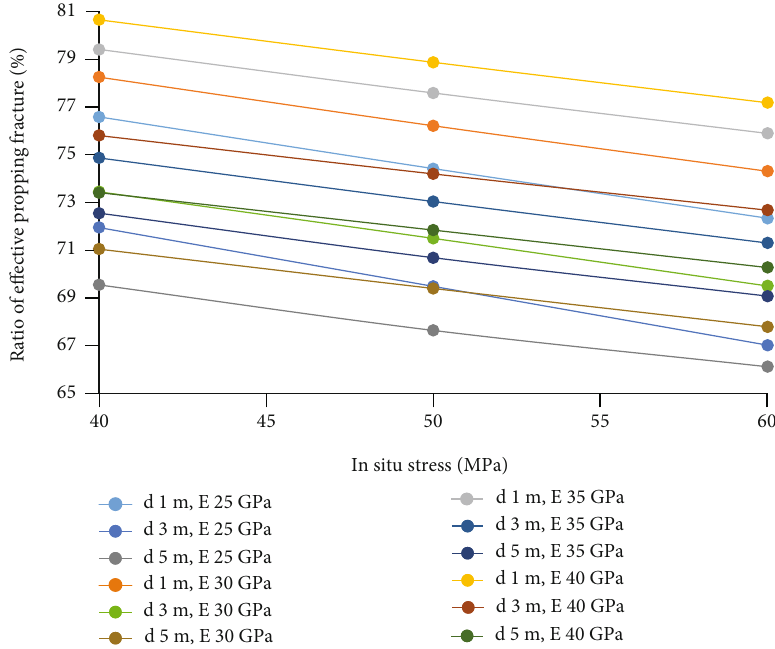
Figure 33: The proppant height is 8 mm, and the in fl uence of in situ stress under di ff erent diameters on the ratio of e ff ective supporting